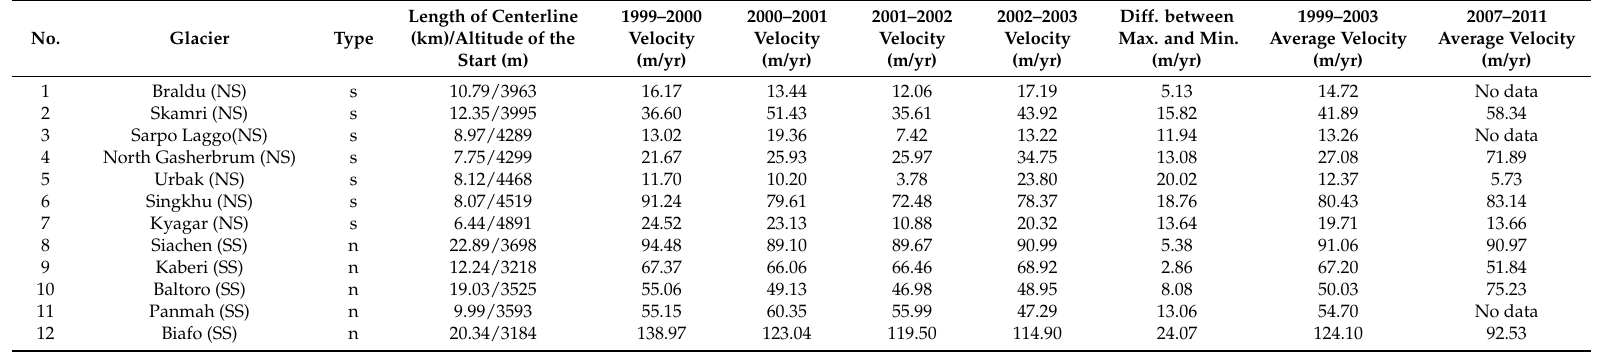
Table 2. Average centerline velocities (limited to the lower 30% of the glacier length along the centerline) of major glaciers over the Central Karakoram from 1999–2003, and average annual velocity during 2007–2011 reported by Rankl et al. [1]. NS denotes that the glaciers locate on the northern slope and SS denotes that the glaciers locate on the southern slope. s = surge-type glacier, n = normal glacier. The locations of the numbered glaciers are marked in Figure 2.